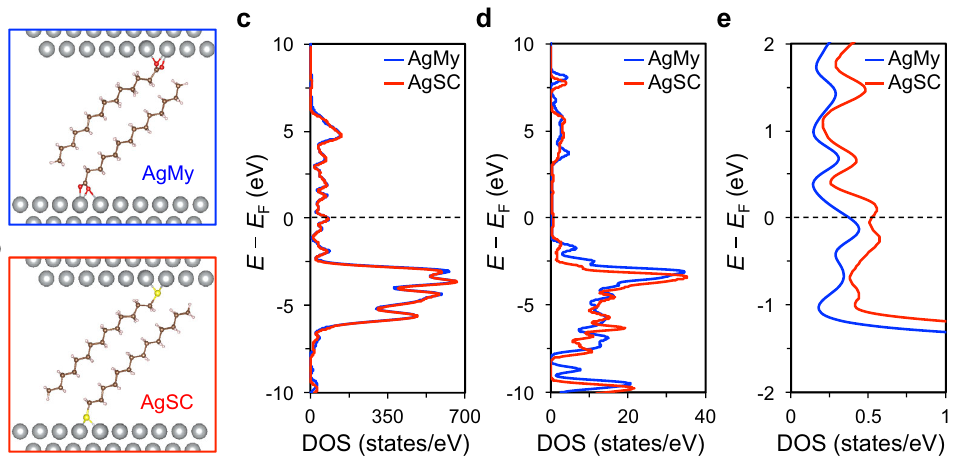
Fig. 2 Comparison of the electron density of states (DOS) between AgMy and AgSC. a , b Optimized structures of the slab model for the calculations: a AgMy and b AgSC. c DOS values of the whole atomic model (total DOS values) of AgMy (blue) and AgSC (red). These DOS values appear to be almost overlapping, because electrons from the Ag atoms are numerically in a majority and are dominant. d DOS values projected for the ligand part of AgMy (blue) and AgSC (red). These DOS values are also almost the same, because the two ligands have the same structure, except for their terminal groups. e Expanded DOS values for the ligand part of AgMy (blue) and AgSC (red) in the range of − 2 to 2 eV. These DOS values are present near the Fermi level because of chemical interactions between the Ag surface and ligands; in addition, the DOS near the Fermi level of AgMy is lower than that of